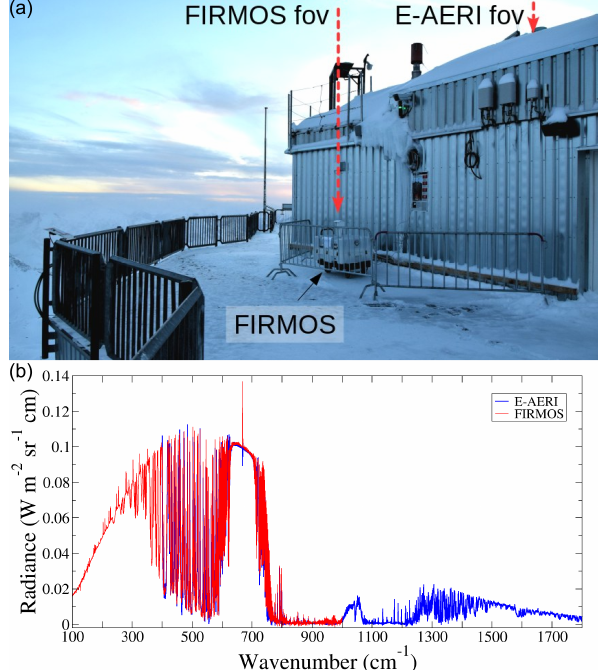
Figure 2. FIRMOS and E-AERI installed at the Summit station (a) . The comparison between the average spectra of 310 simultaneous observations acquired by the two instruments in clear sky during 2019 campaign is shown in (b)